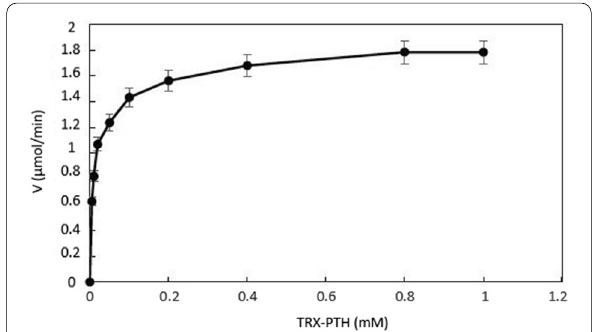
Fig. 6 Michaelis–Menten saturation curve for the enzyme reaction